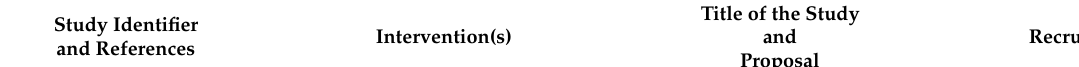
Table 1. Clinical trials approved for the use of n-3 PUFAs for COVID-19